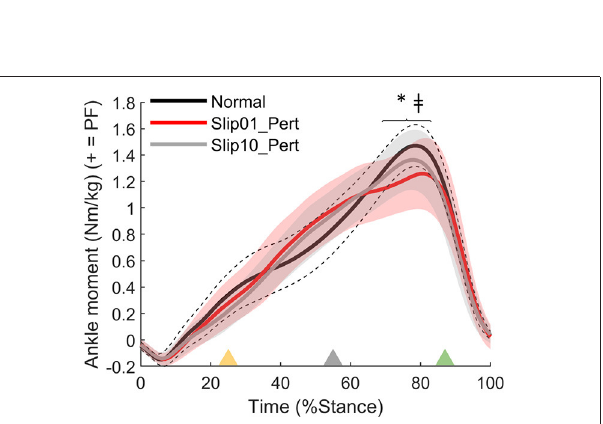
FIGURE 5 | Ankle moment, effect of condition between Normal (average: solid black line; standard deviation: dotted black lines), Slip01_Pert (average: solid red line; standard deviation: red shaded area), and Slip10_Pert (average: solid grey line; standard deviation: grey shaded area). *: significant difference between Normal and Slip01 (69–83% stance, p = 0.002); ‡: significant difference between Slip01 and Slip10 (70–79% stance, p < 0.001). Yellow triangle: beginning of belt acceleration; grey triangle: peak belt speed; green triangle: belt speed returns to 1.2 m · s − 1 . See Supplementary Figure 5 for YA and OA